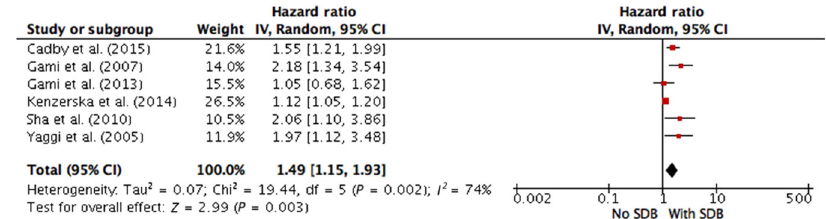
Fig. 4 Meta-analysis of association between sleep-disordered breathing and risk of cardiovascular disease (hazard ratios) in a population at high risk of SDB. Cadby et al. (2015) AHI cut-off 5, outcome — atrial fi brillation; Gami et al. (2007) AHI cut-off 5, outcome — incident atrial fi brillation; Gami et al. (2013) AHI cut-off 20, outcome — sudden cardiac death; Kenzerska et al. (2014) AHI cut-off 5, outcome — myocardial infarction, stroke, congestive heart failure, revascularization procedure, all-cause death; Sha et al. (2010) AHI cut-off 5, outcome — cardiovascular disease; Yaggi et al. (2005) AHI cut-off 5, outcome — incident stroke/TIA or all-cause mortality. AHI apnea-hypopnea index, CI con fi dence interval, IV inversed variance, SDB sleep-disordered breathing.